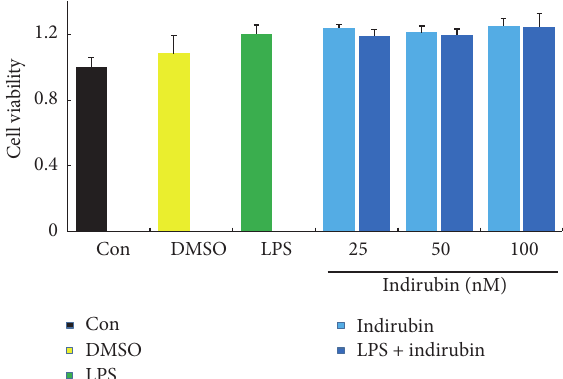
Figure 3: Effects of indirubin on the cell viability in MMECs. The values are presented as the means ± SEM of three independent